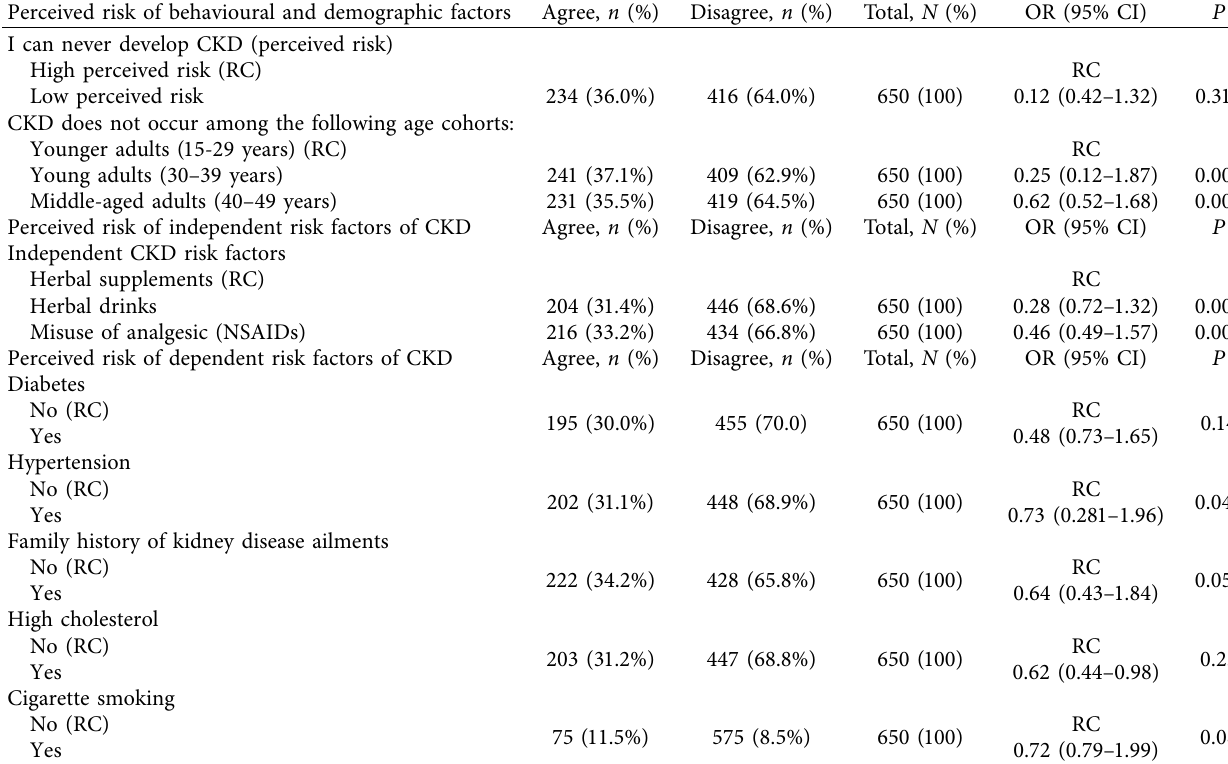
Table 4: Self-reported perceived risk of factors influencing behavioural, demographic, and risk factors for CKD among respondents. Perceived risk of behavioural and demographic factors